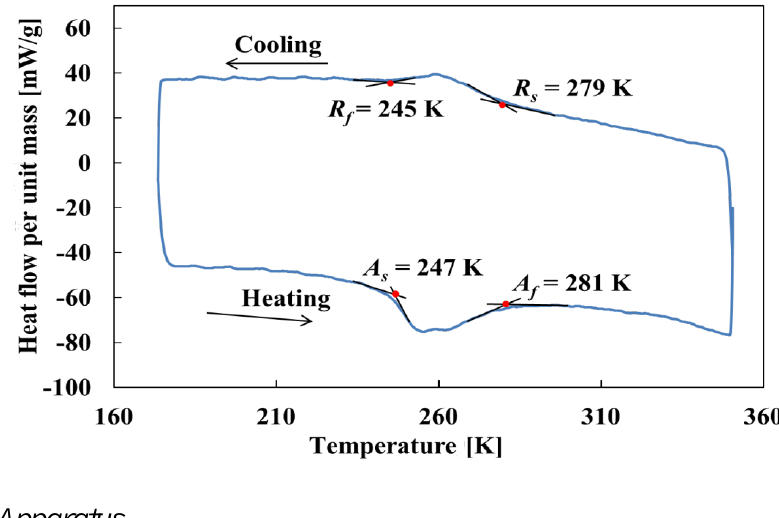
Figure 2. Differential scanning calorimetry (DSC) thermogram for material used in the